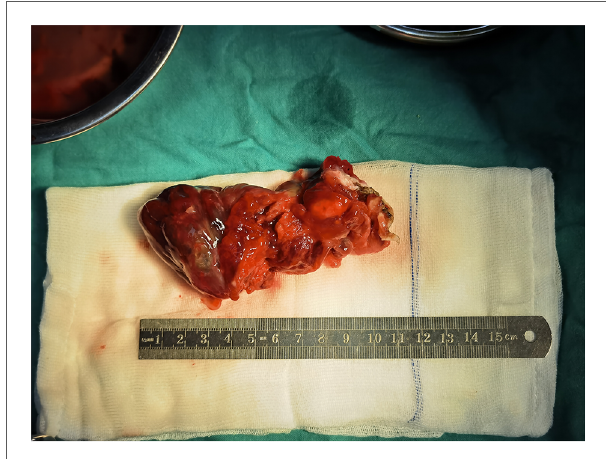
FIGURE 2 The patient underwent a resection of the mass (measuring 110×51× 43 mm).